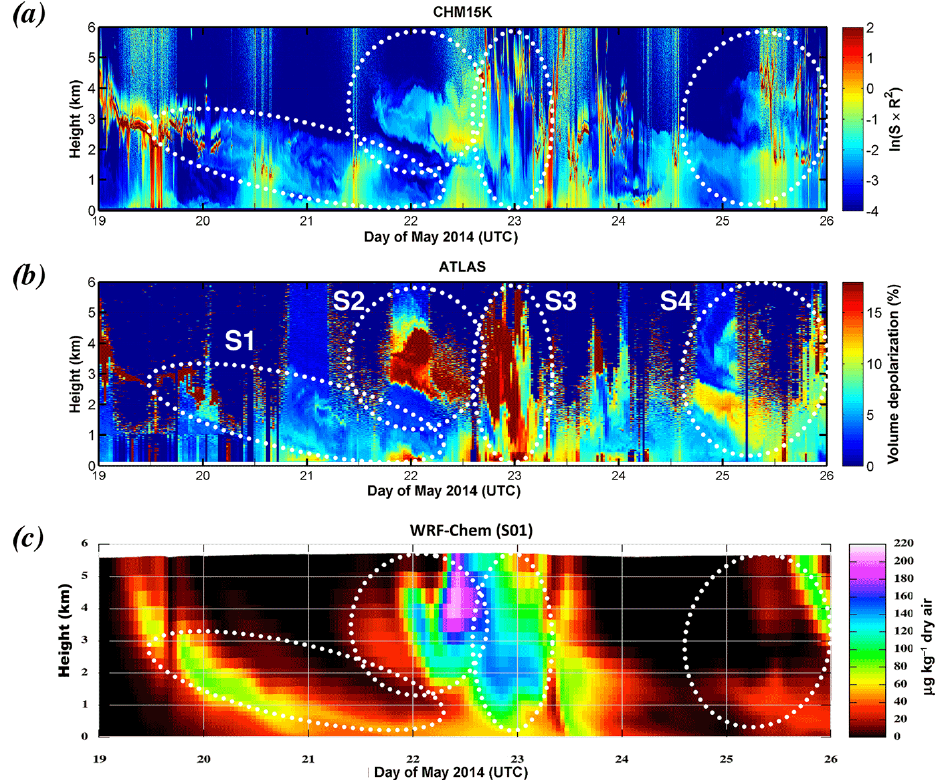
Figure 7. Continuous (h24) temporal evolution (19–25 May, x axis) of the vertically resolved (0–6km, y axis) aerosol field over Rome as observed/modeled by (a) the CHM15K ceilometer (aerosol-produced range corrected signal, RCS), (b) the ATLAS lidar (aerosol-induced volume depolarization, D , %), and (c) the WRF-Chem S01 scheme (total dust mass, µgkg − 1 dryair